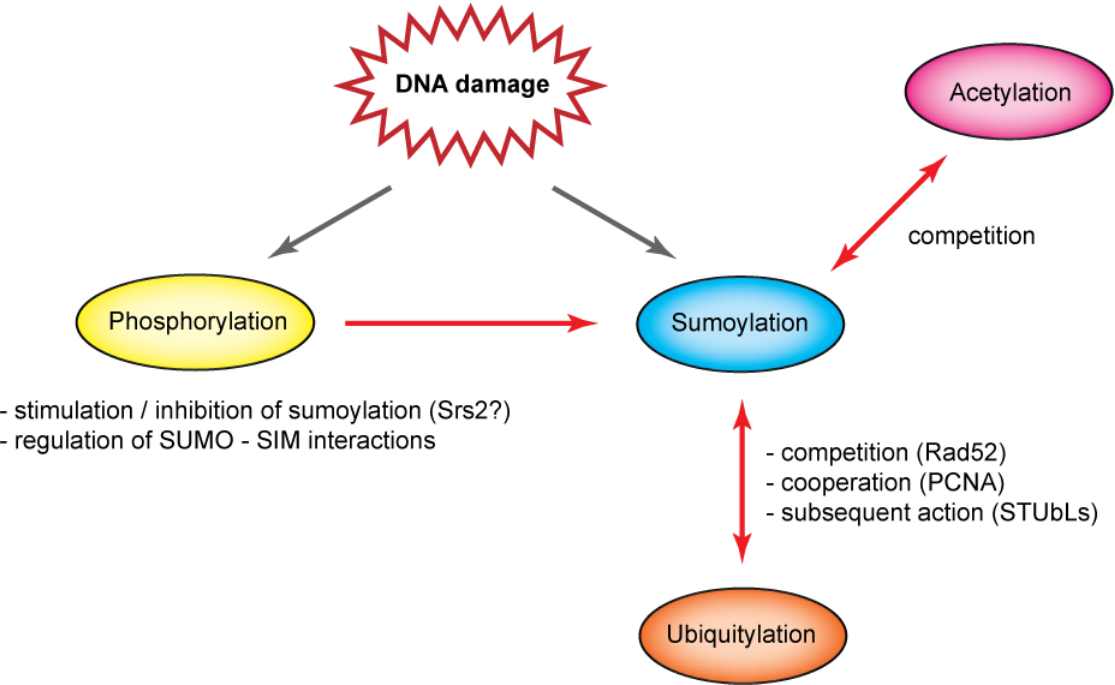
Figure 3. The interplay between sumoylation and other post-translational modifications. Sumoylation does not exist alone but is often influenced by and itself affects other PTMs. Phosphorylation can influence sumoylation both in positive as well as negative manner and also regulate interaction between SUMO and SIM motif in various proteins. Furthermore, acetylation can compete with sumoylation for the same lysine residue, similarly to ubiquitylation that was also reported to cooperate or lead to subsequent reaction with sumoylation. See text for more